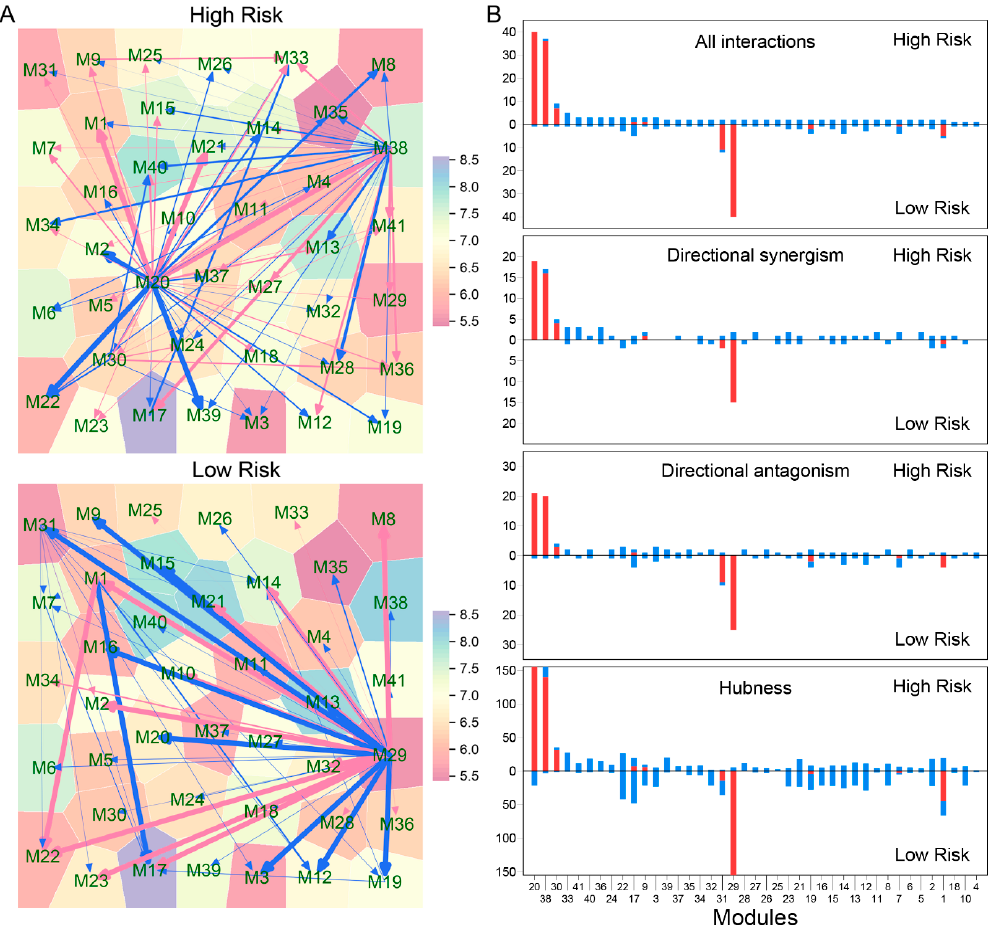
Figure 4. idopNetworks identified at the module level. ( A ) Networks among 41 modules for high- and low-risk groups. Arrowed red and blue lines denote promotion and inhibition, respectively, with the thickness of lines being proportional to the strength of promotion or inhibition. ( B ) The distribution of the total number of interactions, the number of directional synergism, the number of directional antagonism, and the hubness across modules for high- (upper) and low-risk groups (lower). Red and blue bars denote outgoing links (regulators) and incoming links (regulated genes), respectively.